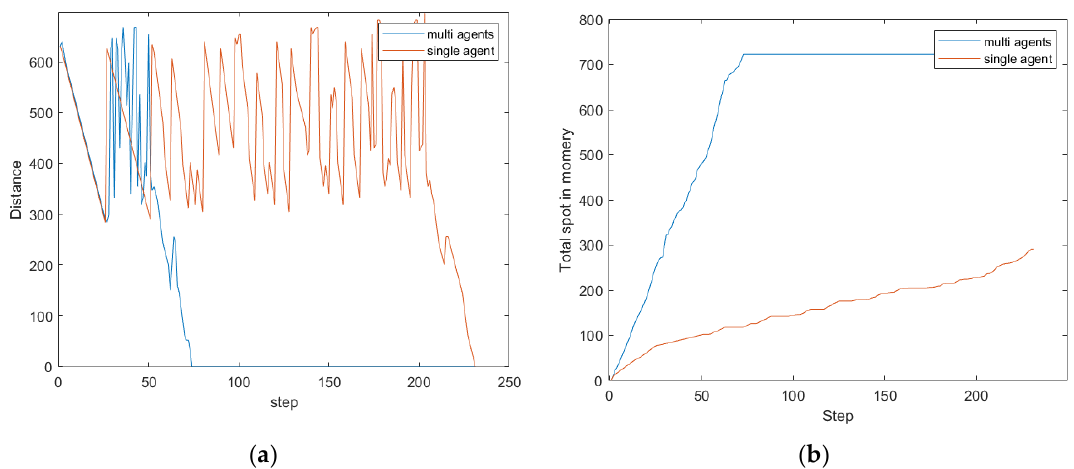
Figure 4. ( a ) Number of steps that the window which has the lowest h score of open set converges the target spot; ( b ) total spots of open set and closed set during the search.